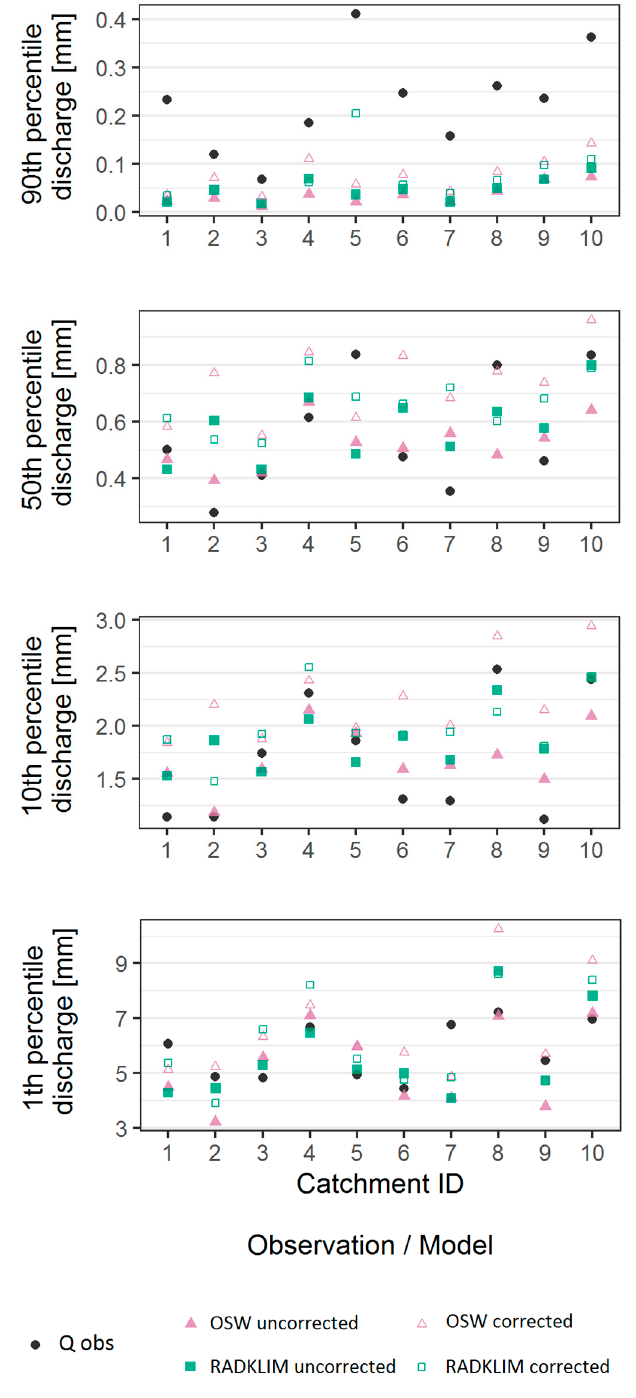
Figure 12. Low (90th percentile), medium (50th percentile), high (10th percentile), and extreme (1st percentile) flow simulated with gauge and radar precipitation with and without Richter corrections.